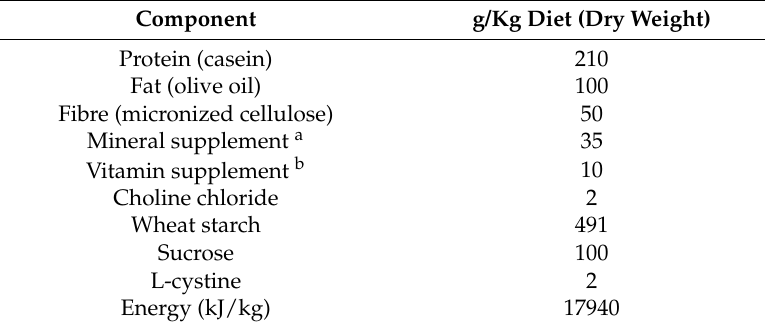
Table 1. Composition of the experimental